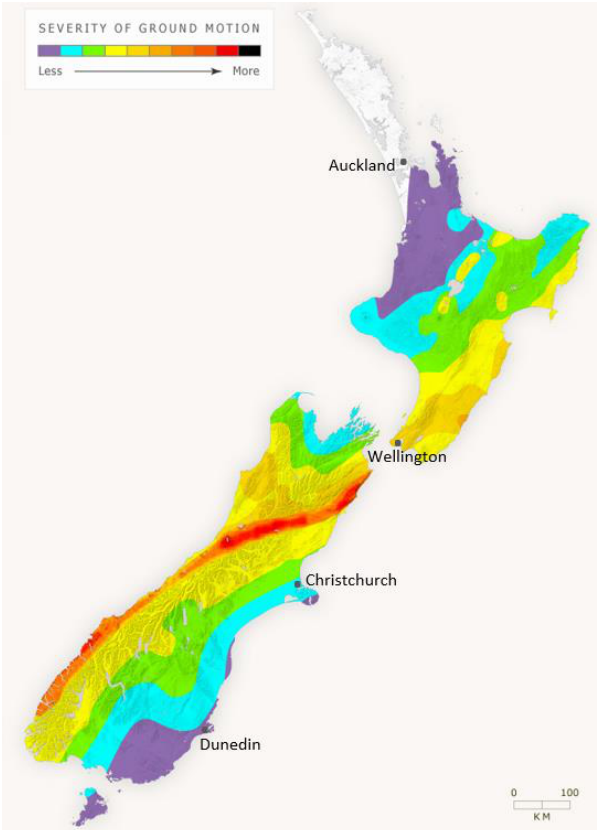
Figure 3. Map showing severity of ground motion in New Zealand. Source: Adapted from McSaveney [1]. Table 3. Barriers and motivators for